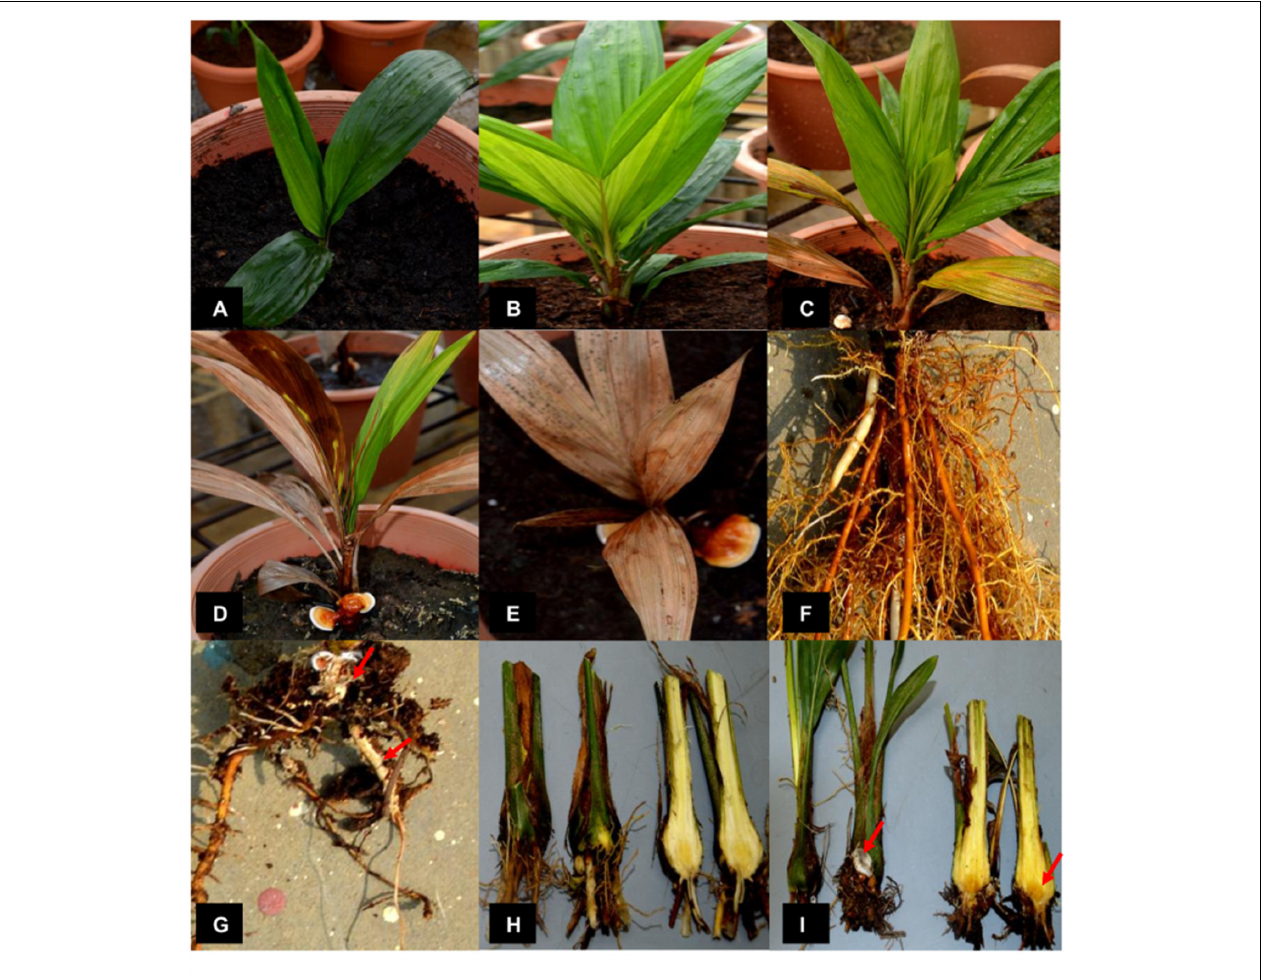
FIGURE 1 | Progression of basal stem rot in 3-month-old oil palm seedlings challenged with Ganoderma boninense . (A) Control (non-inoculated) seedling. (B) Asymptomatic infected (inoculated) seedling at 4 weeks post-inoculation (wpi). (C) Infected seedling at 8 wpi with at least 2 or more yellowing leaves. (D) Infected seedling at 12 wpi with al least three or more browning leaves and visible fruiting bodies. (E) Infected seedling at > 12 wpi shows complete necrosis. (F) Healthy roots of a control seedling. (G) Roots of an infected seedling show colonization by G. boninense (red arrows indicate mycelium attachment). (H) Boles of the control seedlings and (I) boles of the infected seedlings show brown coloration. Red arrow-indicates sporophore (left) and necrosis